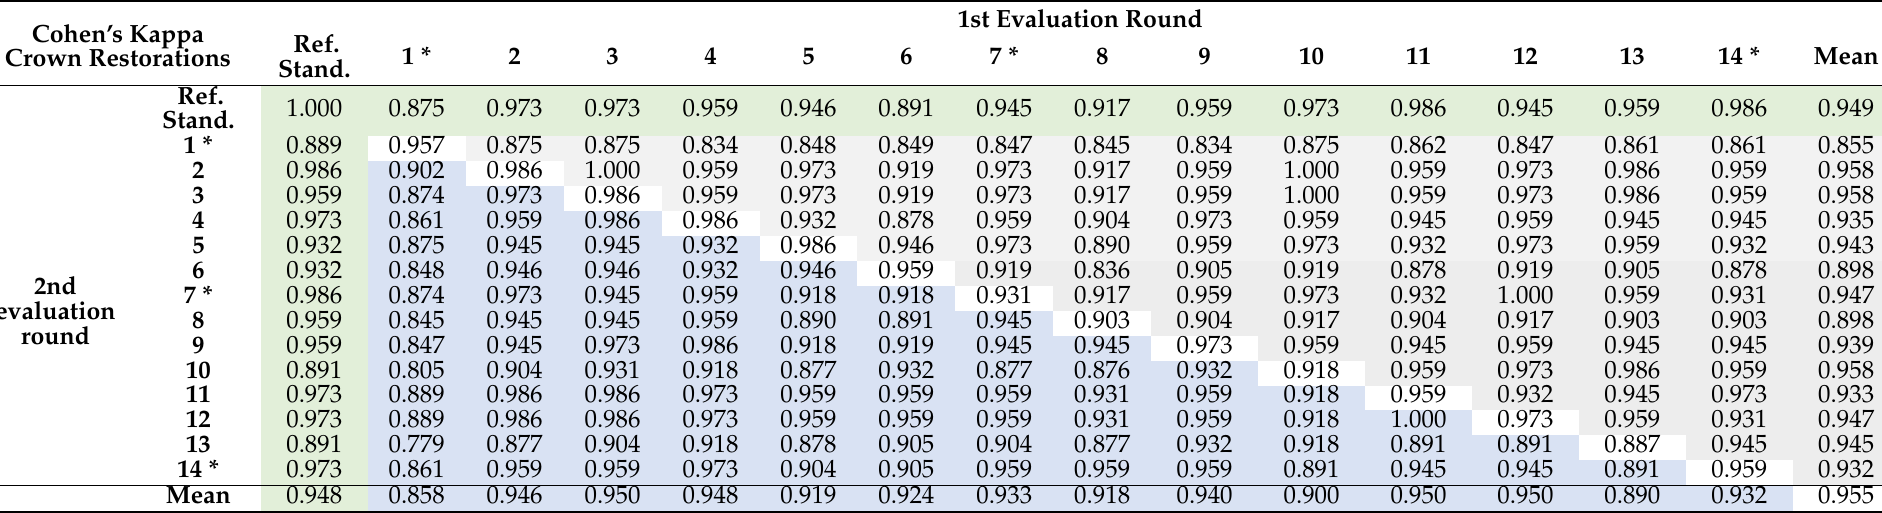
Table 2. Inter- and intra-examiner reliability values for the detection of crown restorations between all examiners (N = 14) and in relation to the reference diagnosis (green background color). Gray background colors indicate inter-examiner CK values of the first evaluation round and blue background colors for the second evaluation round. Fields with a white background color represent intra-examiner CK